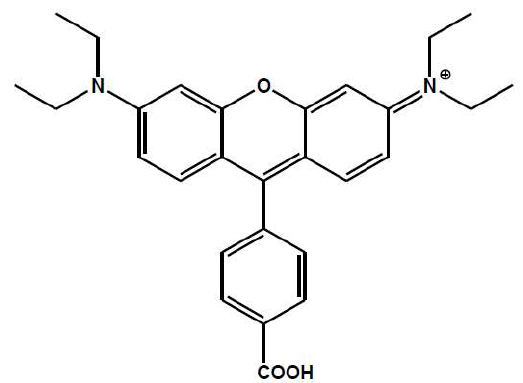
Figure 1. Schematic structure of the rosamine B molecular